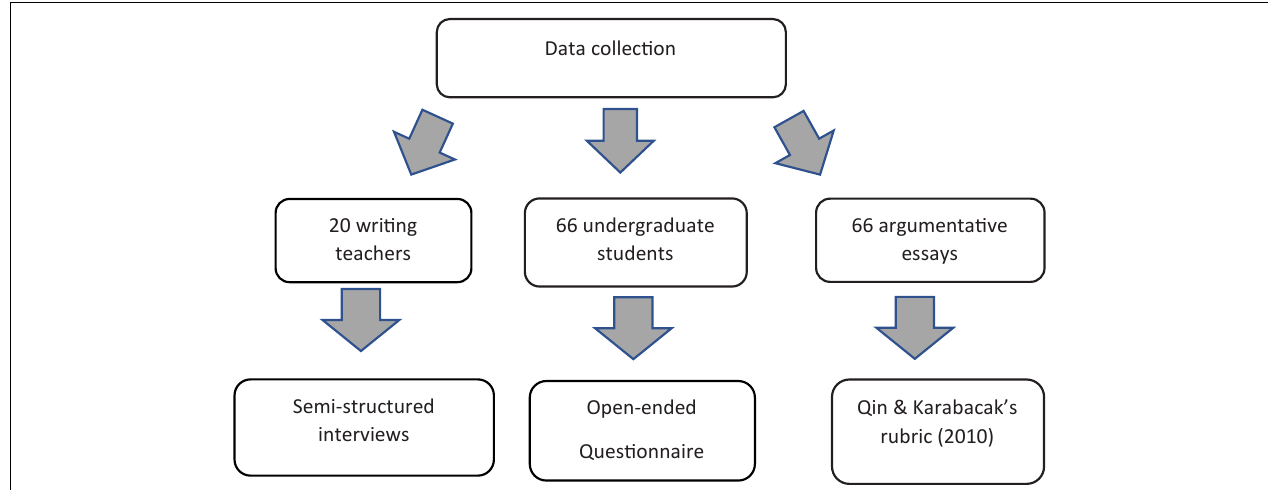
FIGURE 2 | Data collection procedure in the